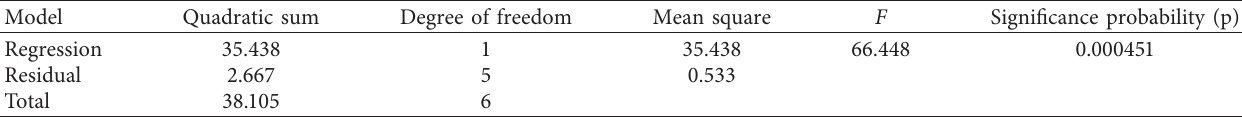
Table 2: Statistical analysis results.